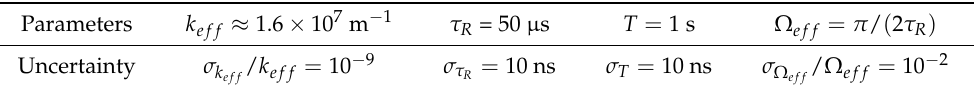
Table 3. CAI parameters for scale factor uncertainty estimations. σ i refers to the uncertainty on the parameter i .